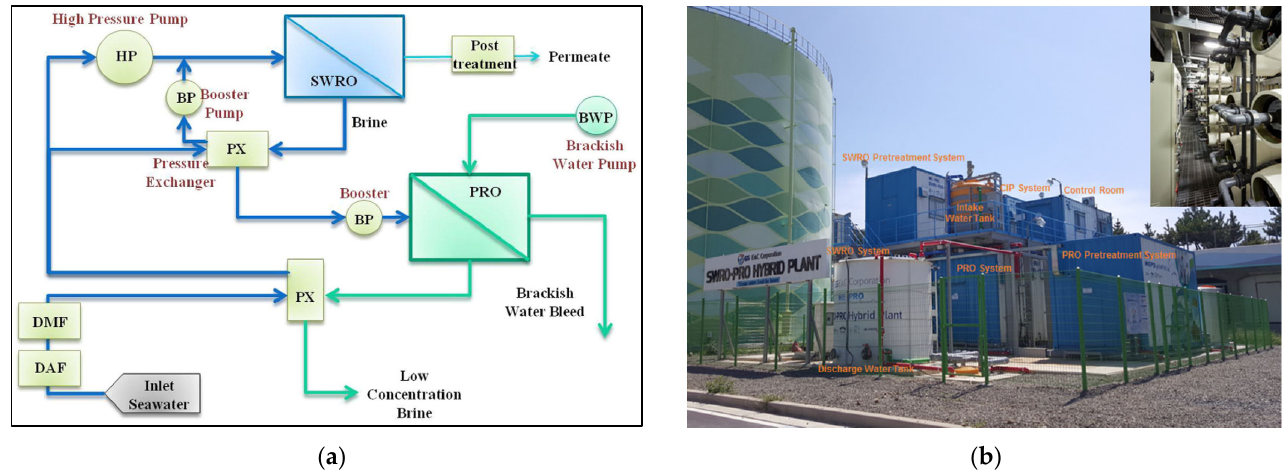
Figure 6. ( a ) Schematic diagram of osmotic dilution seawater reverse osmosis–pressure-retarded osmosis (SWRO–PRO) desalination hybrid pilot plant, ( b ) reverse osmosis (RO)–PRO hybrid desalination pilot with SWRO water production capacity of 240 m 3 /day [46,48] .